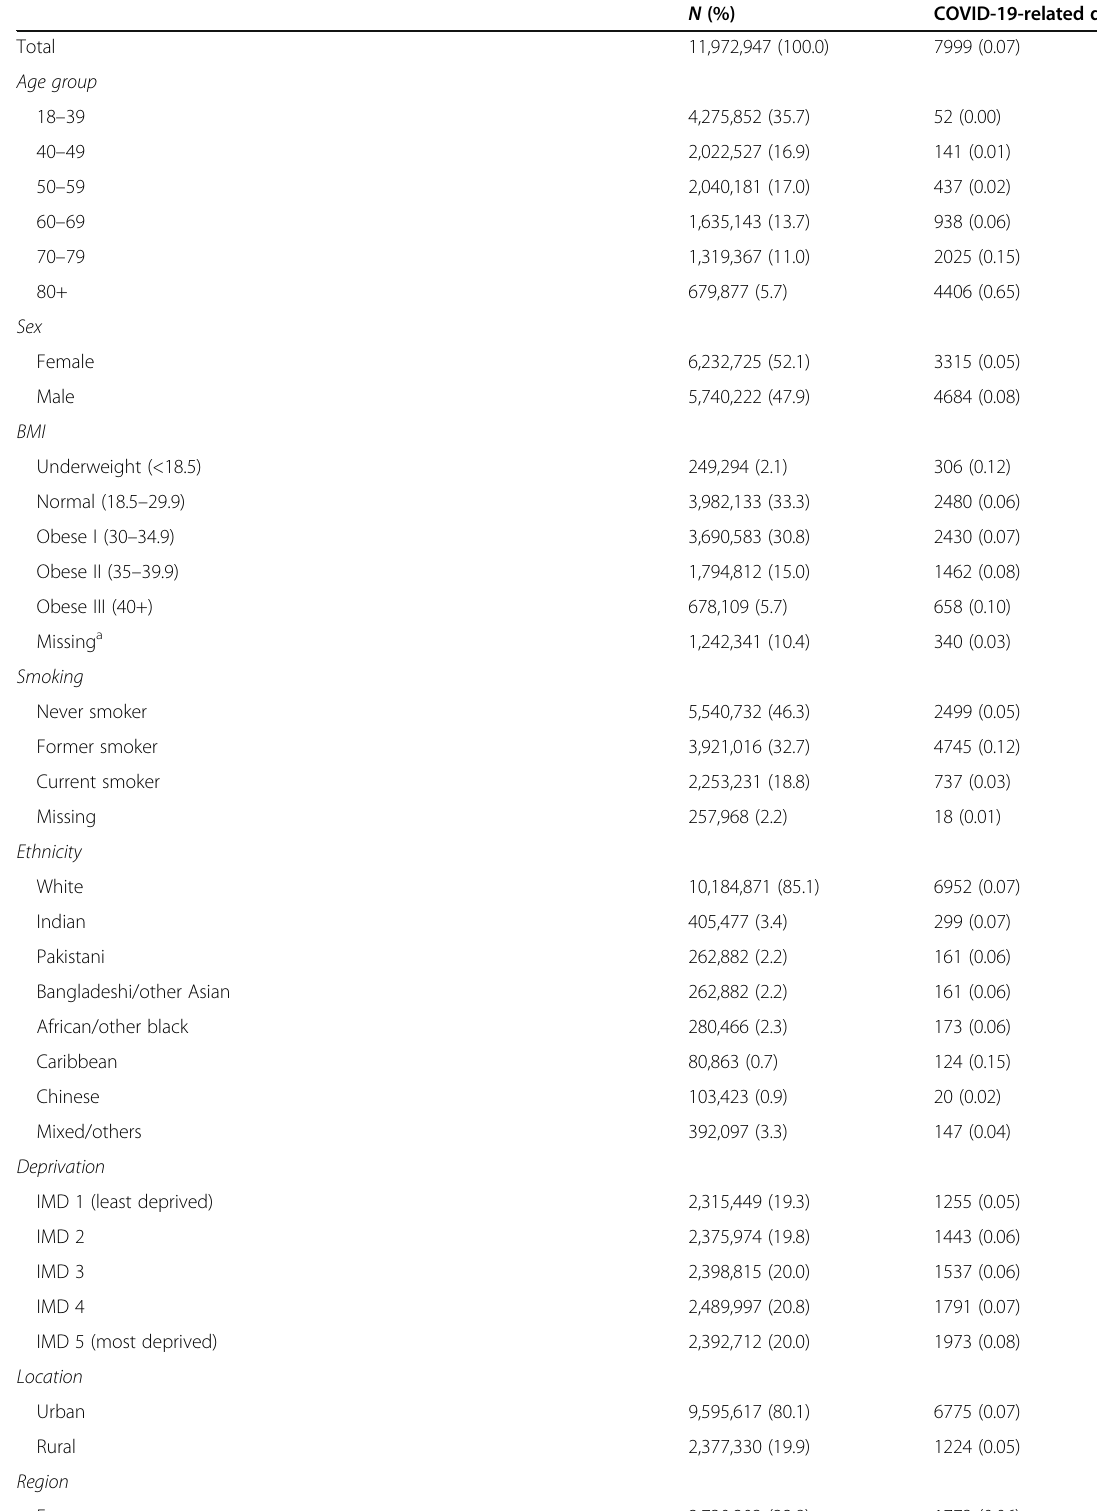
Table 1 Description of base